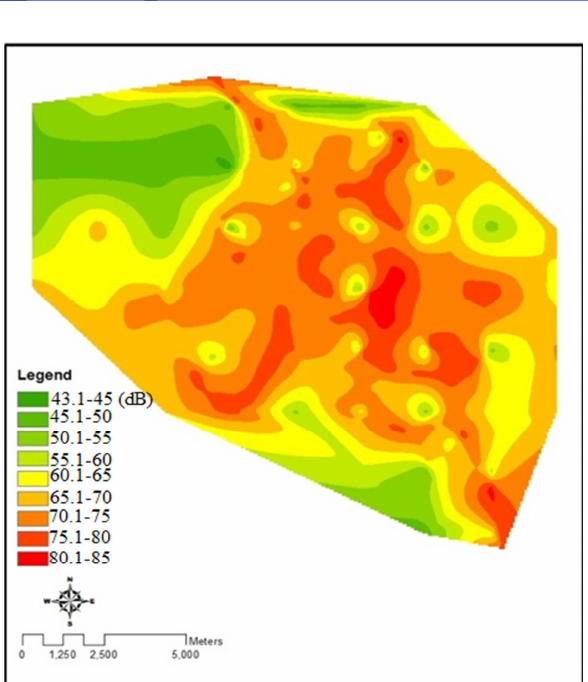
Figure 3. Noise map of Yazd